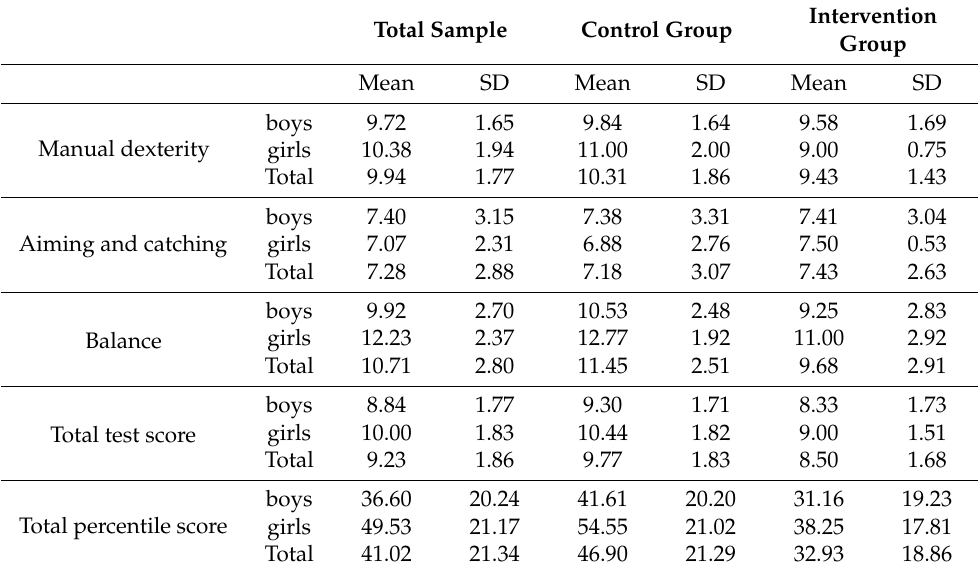
Table 2. Results of MABC-2 test before intervention based on the type of group and gender. Total